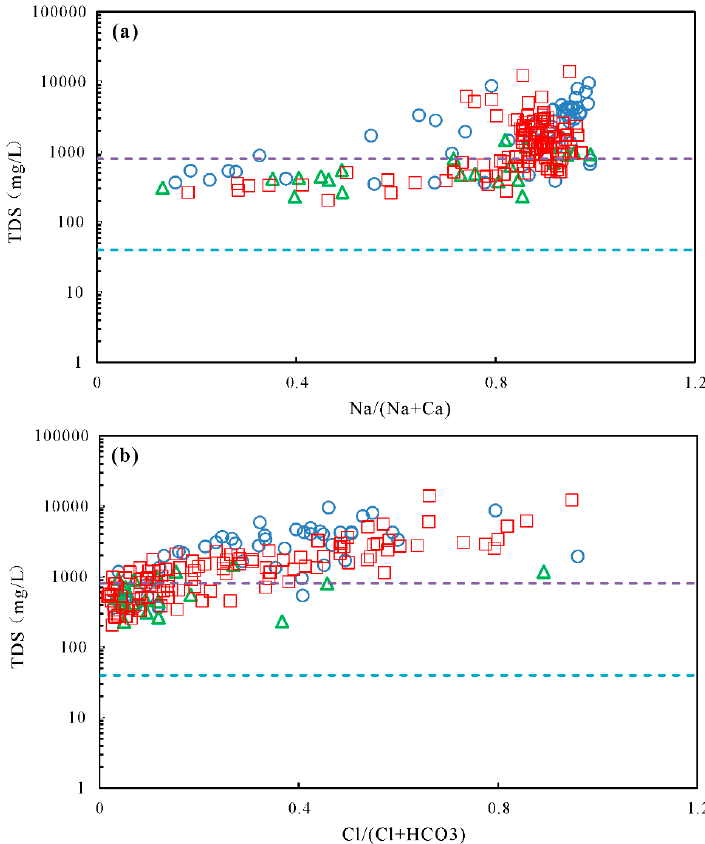
Figure 6. Gibbs plots of TDS vs. Na + /(Na + + Ca 2+ ) (a) and TDS vs. Cl − /(Cl − + HCO 3 − ) (b). Legend for groundwater samples: ○ shallow, △ intermediate, □ deep.